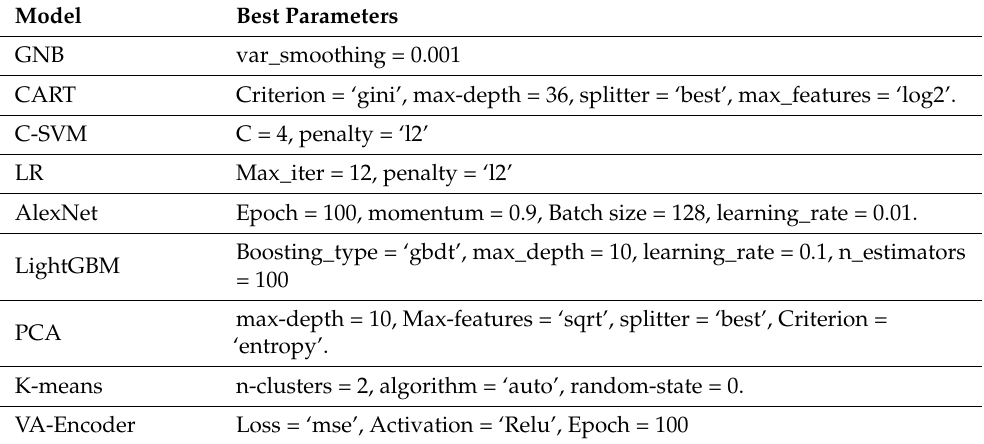
Table 3. Best Parameters Settings Based on Optimization Techniques.